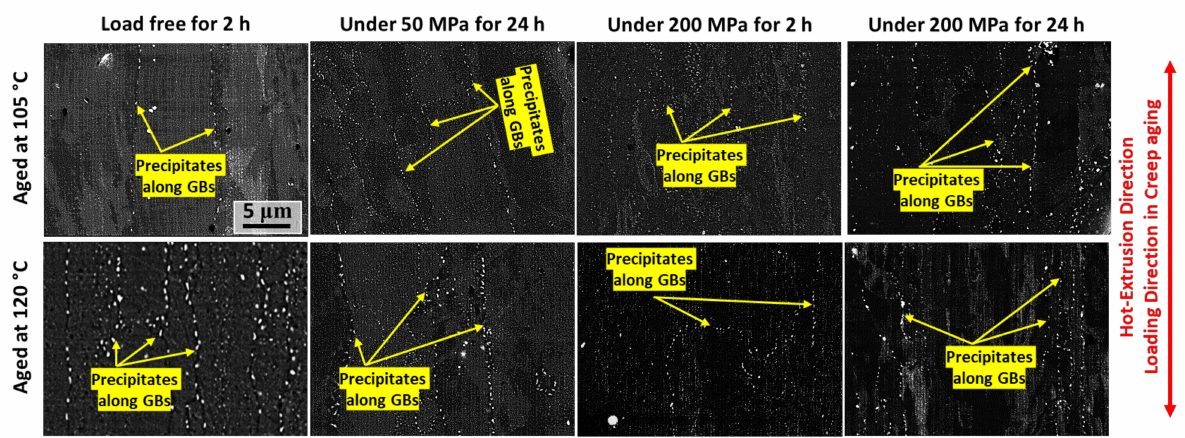
Figure 7. Back-scattered electron (BSE) contrast images of samples aged under different conditions. All images were captured at the same magnification (see text for details).